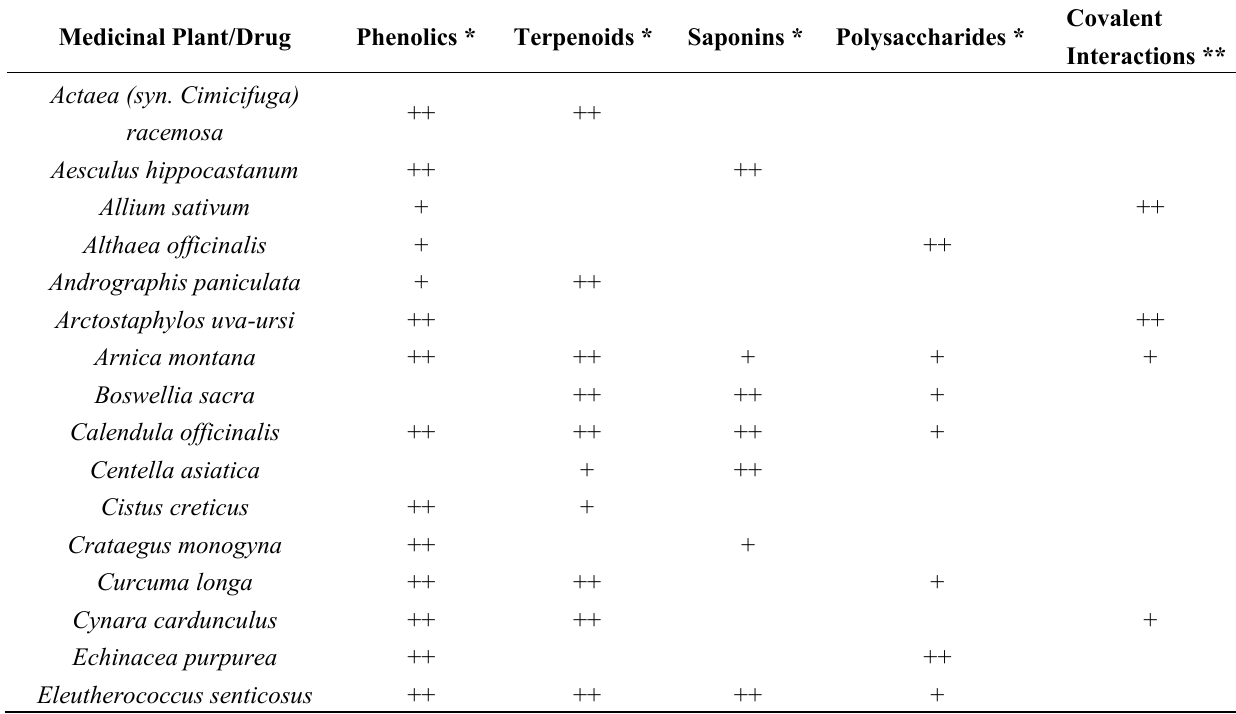
Table 2. Composition of extracts from medicinal plants used in traditional phytotherapy and their putative interactions